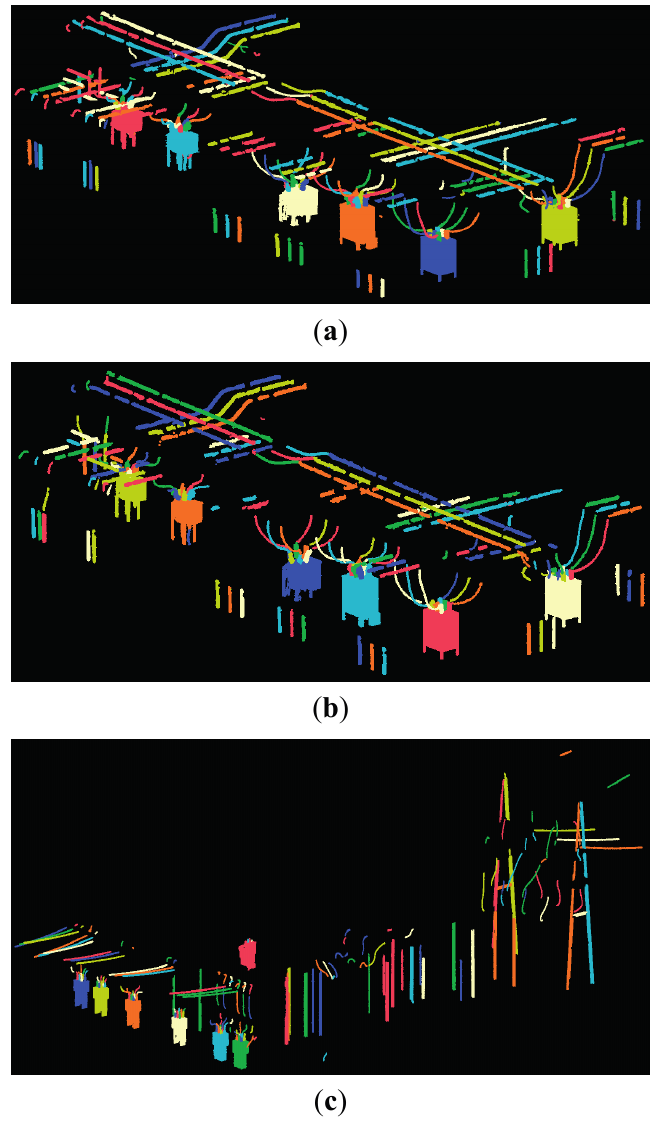
Figure 21. A finer-level of representation of recognized objects in the first dataset ( a ), second dataset ( b ) and third dataset ( c ). Each color represents a separate object that can be of any